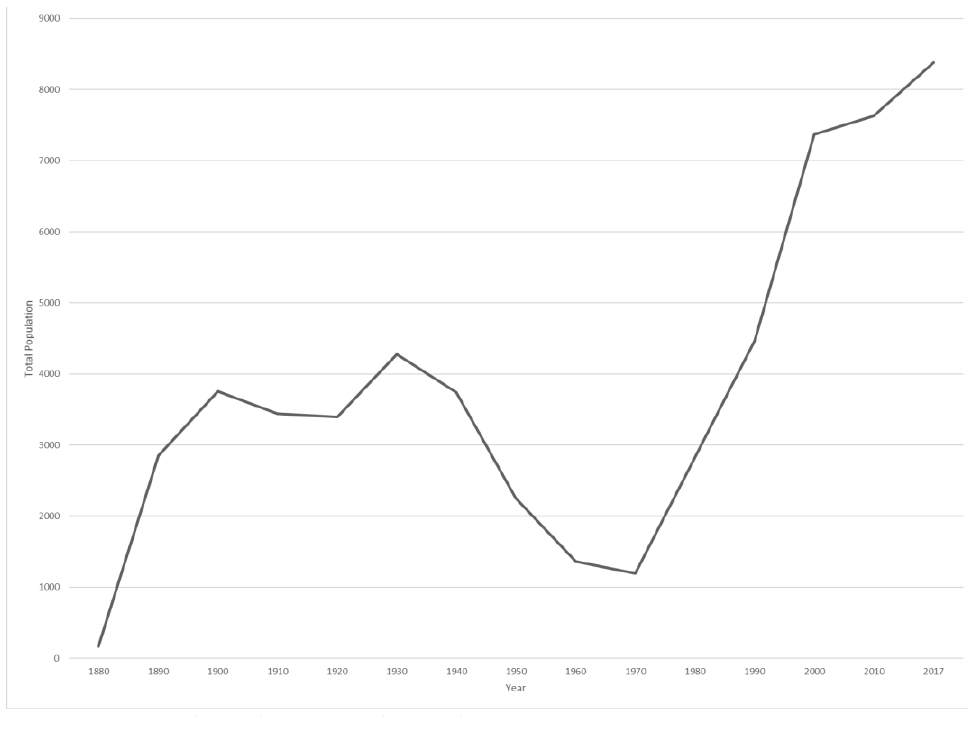
Figure 2. Historical population growth in park city.